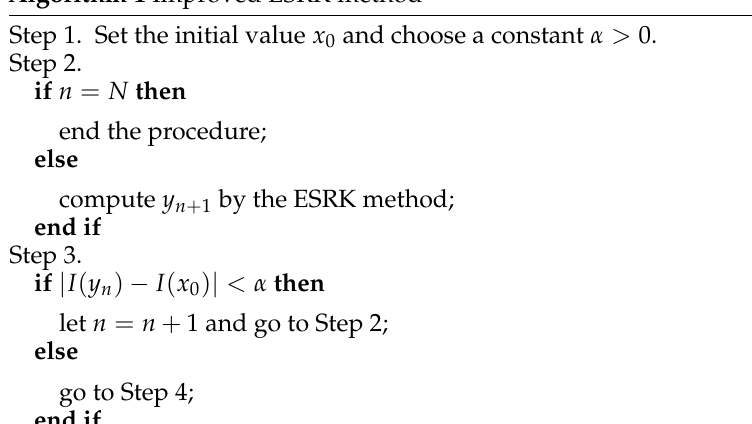
Algorithm 1 Improved ESRK